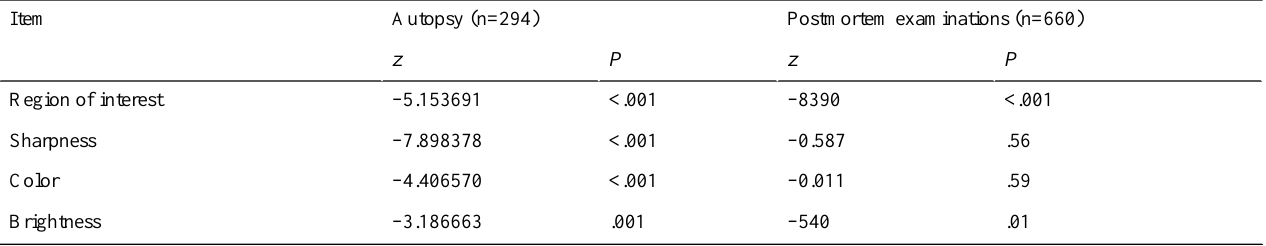
Table 5. Unpaired rank sum, 2-sided Mann-Whitney U (Cronbach alpha=.05) for ratings of autopsy and postmortem examination images taken by digital single-lens reflex (DSLR) camera and Google